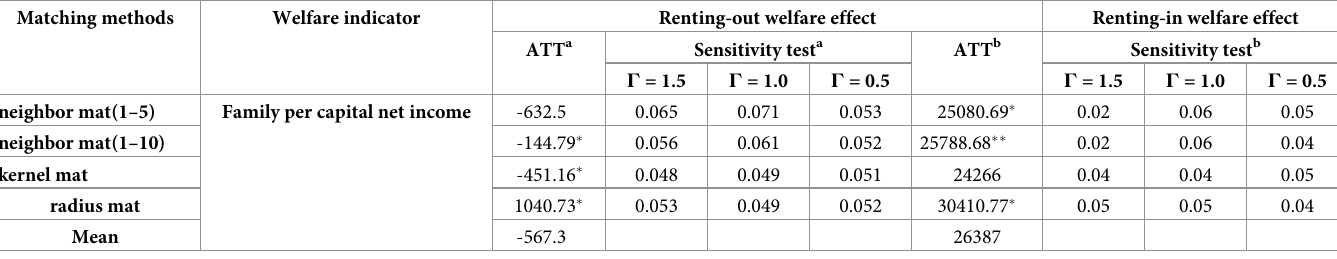
Table 6. The net income effect of the rural land rental